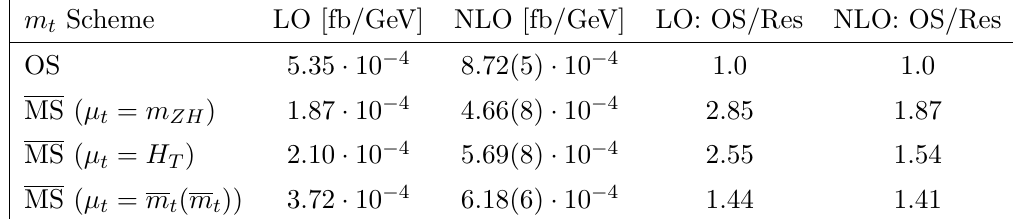
√ s = 14 TeV in the